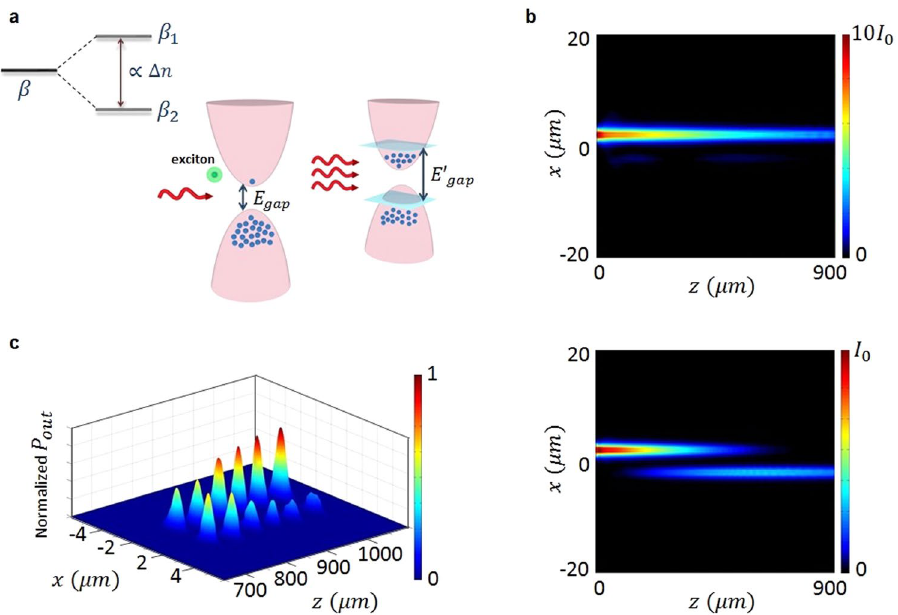
Figure 3. Optical propagation dynamics in the ND elements. ( a ) The large nonlinearity results from the presence of electrons in the conduction band because of absorption, leading to exciton saturation as well as free-carrier-plasma and band-filling effects. The degeneracy between the two propagation eigenvalues is nonlinearly broken. ( b ) Simulations of optical transport in the ND elements under nonlinear (top) and linear (bottom) conditions. The amplified signal traverses the ND section within the same waveguide element because of nonlinear detuning (top), whereas at lower power levels the lightwave crosses over (bottom) in properly designed structures. ( c ) Experimental measurements of the output power from ND arrangements having different lengths (linear regime). These measurements are used to fabricate and design a re-routing device with an optimum extinction